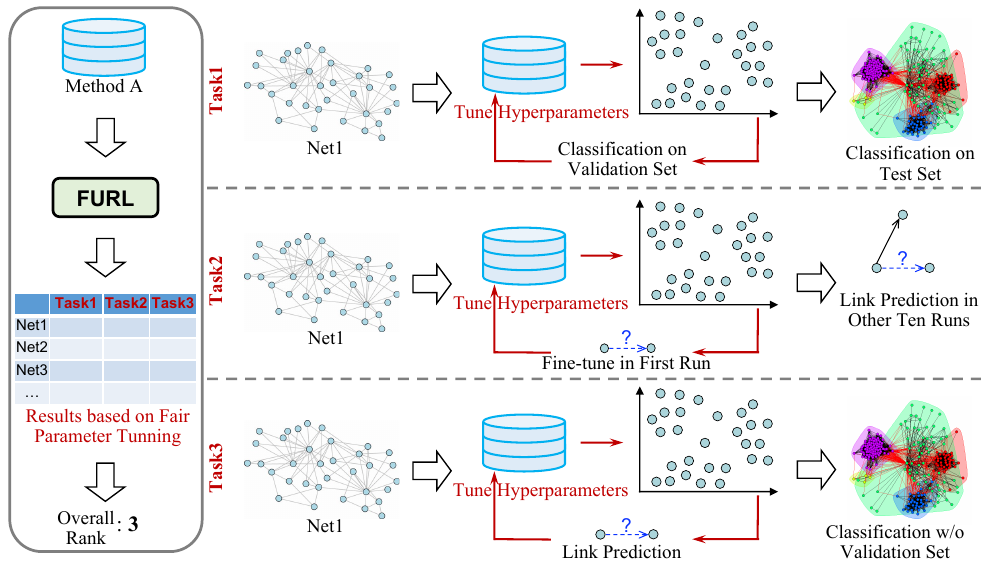
Figure 2. Given a node representation learning method (e.g., Method A), FURL could fairly and comprehensively evaluate it based on its performance on three tasks and many real-world net- works/datasets. The three tasks are classification fine tuned via a validation set, link prediction fine-tuned in the first run, and classification fine tuned via link prediction. In each task, the hyperpa- rameters of Method A are fine-tuned based on a random